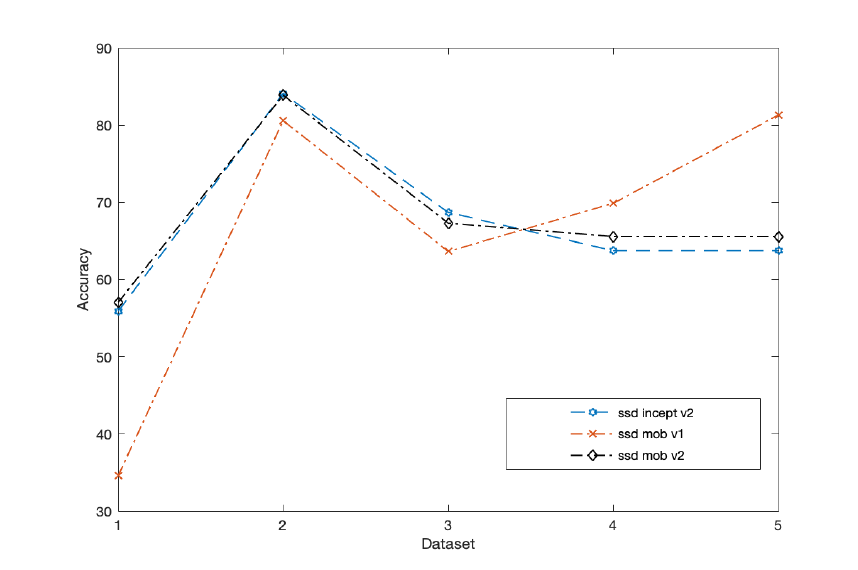
Figure 8. Accuracy vehicle detection.